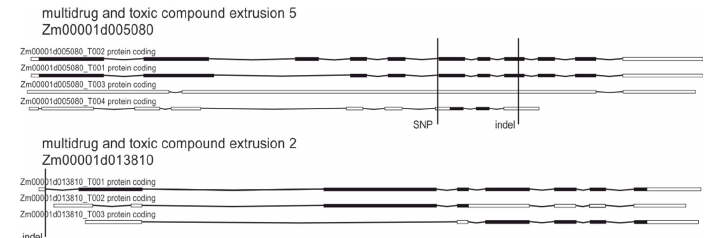
Figure 7. Genetic variations in selected genes encoding proteins involved in multidrug and toxic compound extrusion.